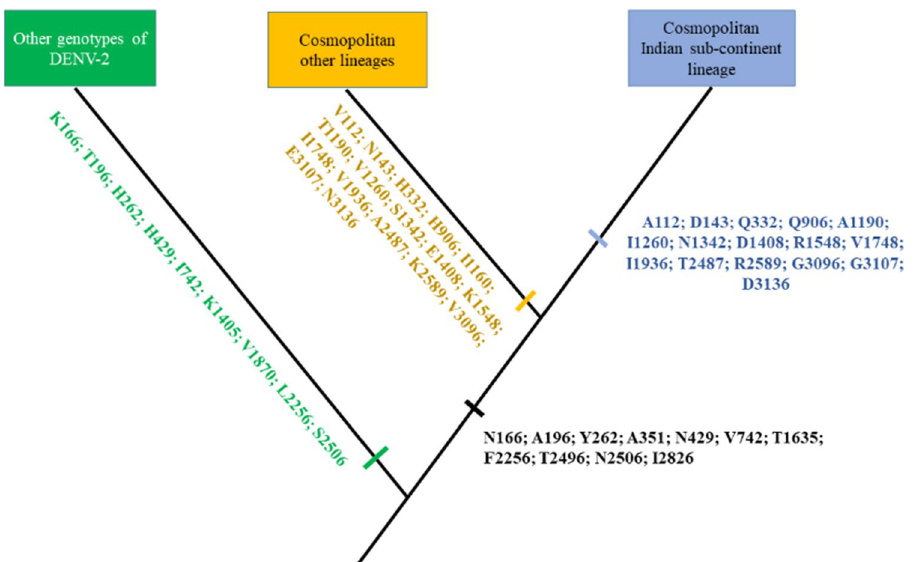
Figure 6. Schematic representation of unique amino acid signatures between Indian sub-continent and other lineages of cosmopolitan genotype. Amino acids are shown in the single letter code, with corresponding polyprotein